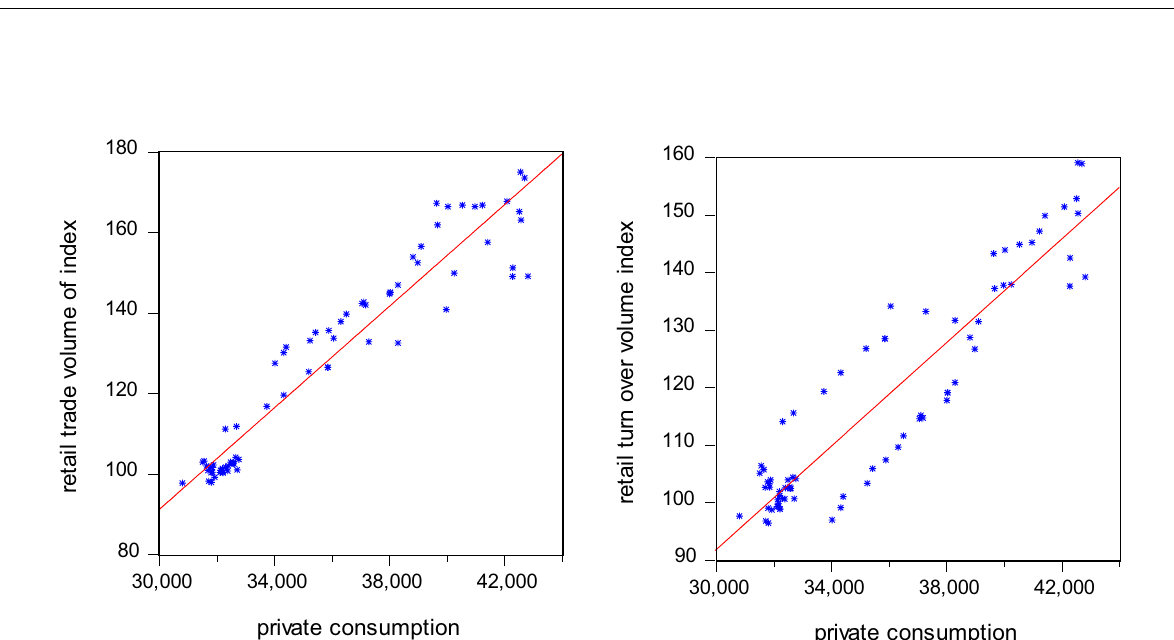
Fig. 1 Relationship between private consumption on goods and services and a retail trade volume of index, b retail turnover volume index. The variables are seasonally adjusted. Period: 2002–2020. Source: Hellenic statistical authority